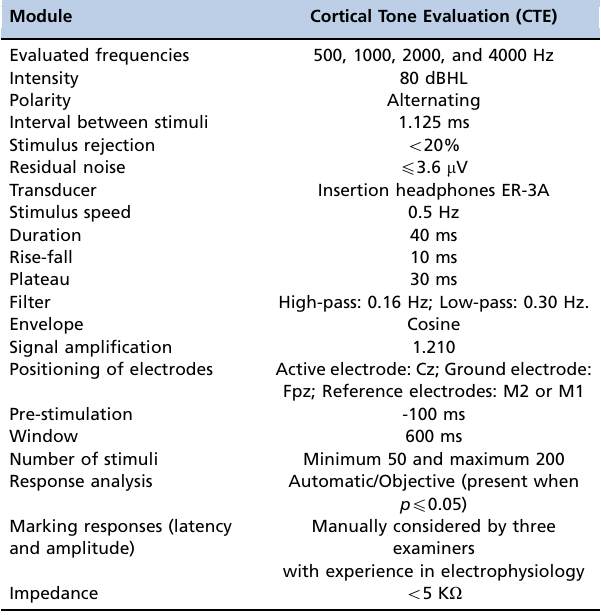
Table 1 - Parameters used to assess the auditory cortical potential P1. Module Evaluated